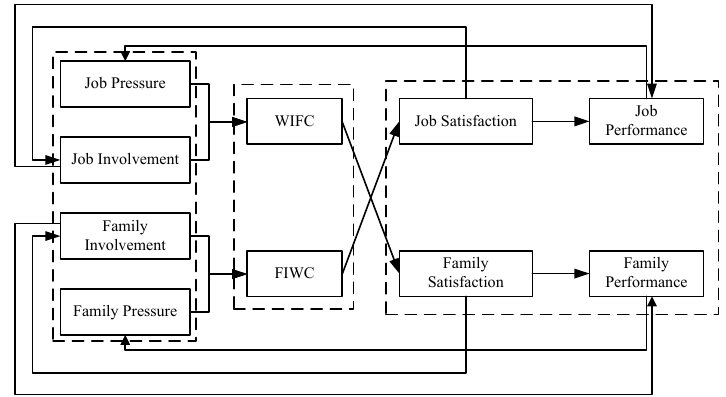
Figure 1. Bi-directional dynamic model framework of Figure1. Bi-directional dynamic model framework of WFC.